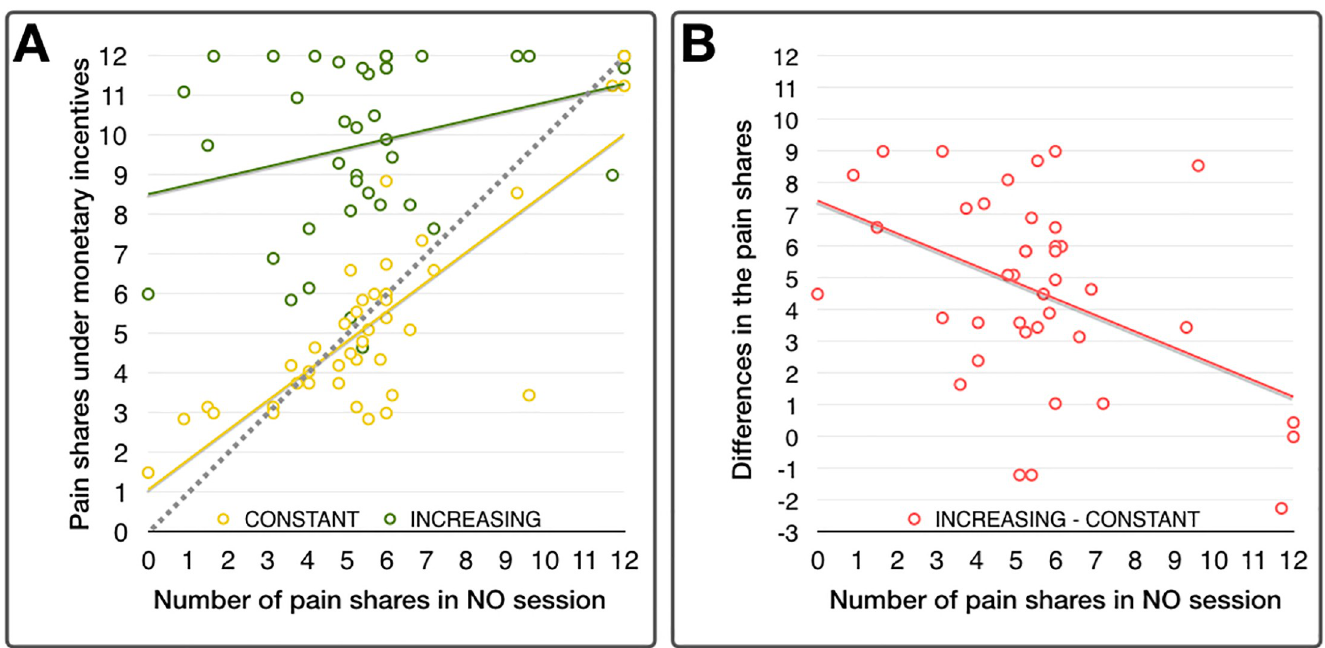
Fig 4. A. Scatterplot of the individuals’ average amount of shared pain during the CONSTANT session and the amount of shared pain during the NO session were significantly and positively correlated, while shared pain during the INCREASING session and during the NO session were correlated without significance. B. Scatterplot of the individuals between the average number of pain shares in the NO session and the differences between the CONSTANT and INCREASING conditions were significantly negatively correlated.